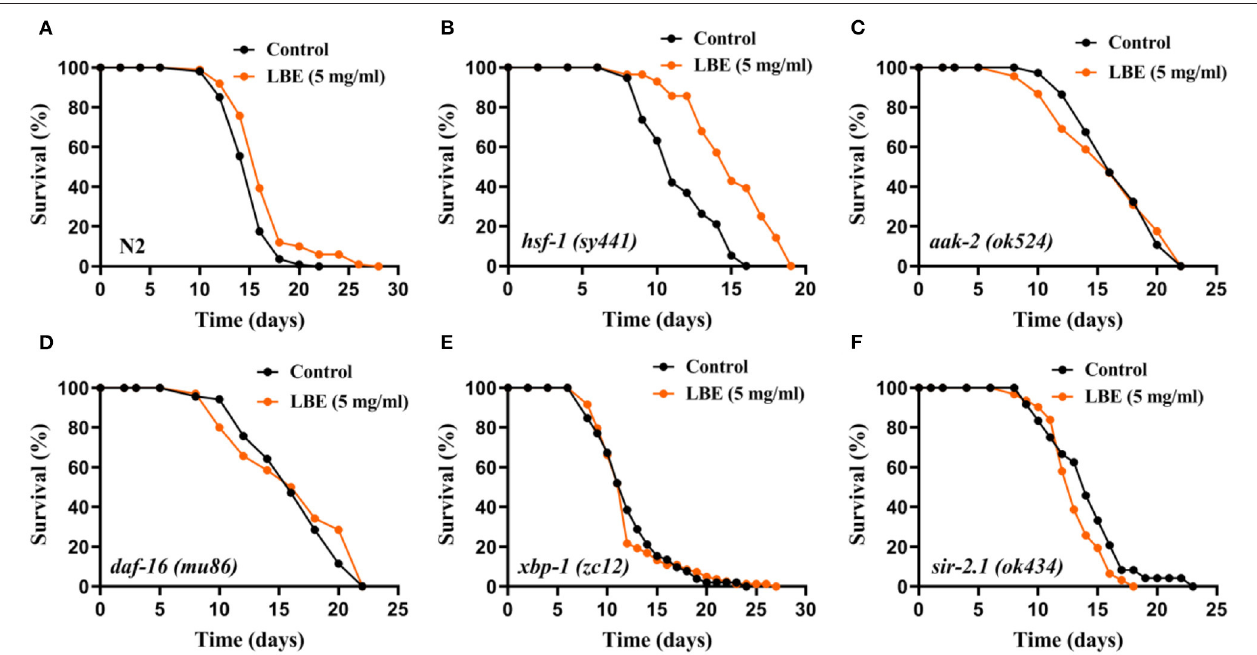
FIGURE 5 | LBE still rescues hsf-1 deficiency in mutant worms under favorable conditions. (A) Survival curves of N2 worms cultured with vehicle or 5 mg/ml LBE at 20 ◦ C (control: n = 108, mean lifespan 15.3 days; 5 mg/ml LBE: n = 99, mean lifespan 16.8 days; p < 0.0001). (B) Survival curves of hsf-1 (sy4421) worms cultured with vehicle or 5 mg/ml LBE at 20 ◦ C (control: n = 19, mean lifespan 11.6 days; 5 mg/ml LBE: n = 28, mean lifespan 15.0 days; p < 0.0001). (C) Survival curves of aak-2 (ok524) worms cultured with vehicle or 5 mg/ml LBE at 20 ◦ C (control: n = 74, mean lifespan 16.8 days; 5 mg/ml LBE: n = 68, mean lifespan 16.1 days; p = 0.910). (D) Survival curves of daf-16 (mu86) worms cultured with vehicle or 5 mg/ml LBE at 20 ◦ C (control: n = 70, mean lifespan 16.3 days; 5 mg/ml LBE: n = 58, mean lifespan 15.1 days; p = 0.299). (E) Survival curves of xbp-1 (zc12) worms cultured with vehicle or 5 mg/ml LBE at 20 ◦ C (control: n = 52, mean lifespan 12.3 days; 5 mg/ml LBE: n = 83, mean lifespan 12.1 days; p = 0.819). (F) Survival curves of sir-2.1 (ok434) worms cultured with vehicle or 5 mg/ml LBE at 20 ◦ C (control: n = 24, mean lifespan 14.1 days; 5 mg/ml LBE: n = 31, mean lifespan 13.2 days; p = 0.113). All the results are representative of at least two independent